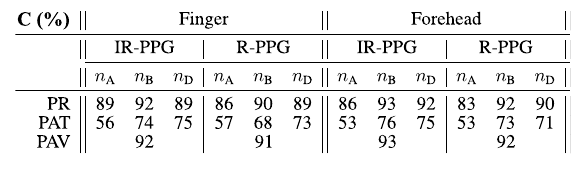
TABLE 3 Coverage results for the TTT dataset. Values of coverage are presented in %, relative to the number of heartbeats (ECG as ground